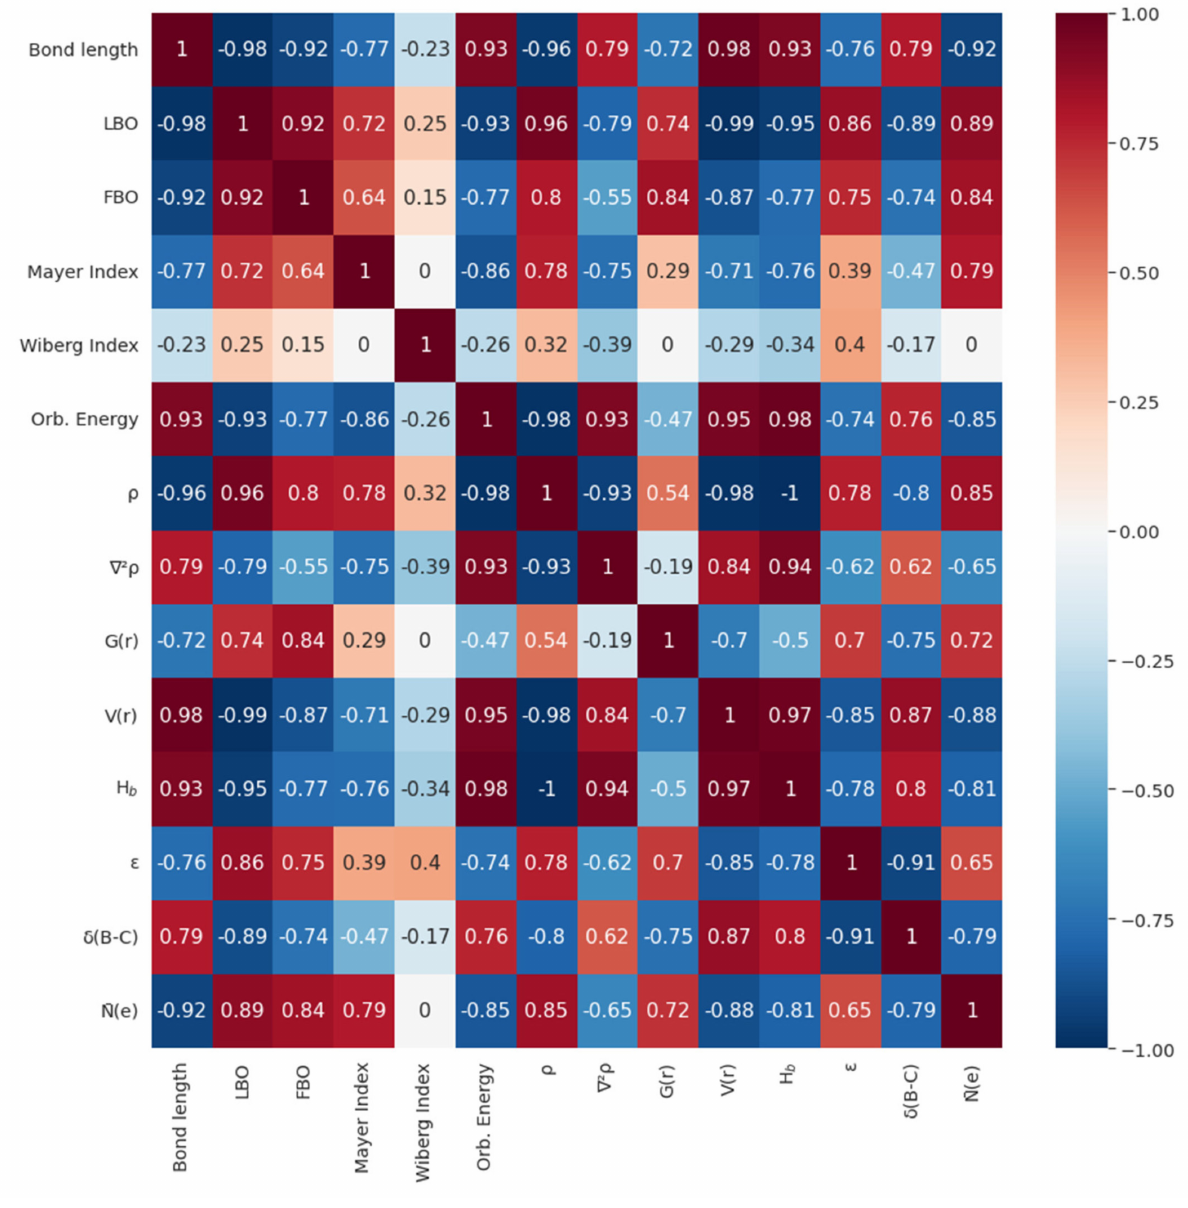
Figure 2. Correlation matrix of main B–C bond descriptors in closo-borate anions of the general form [B n H n − 1 CH 3 ] 2 − (n = 6, 10, 12), monocarboranes [CB n H n CH 3 ] − (n = 5, 9, 11) and BH 3 − n (CH 3 ) n (n = 1–3). For monocarboranes, only exo -polyhedral B–C bonds were